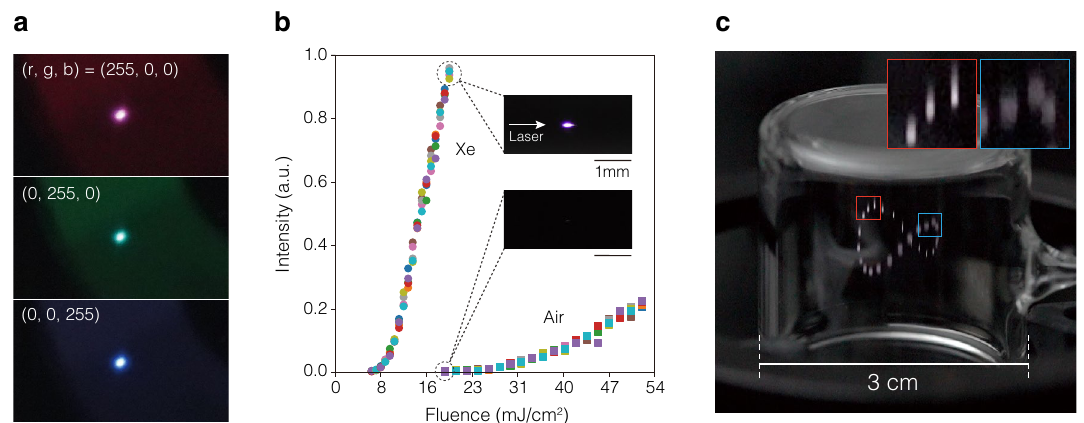
Figure 3. Femtosecond-laser-excited voxels. ( a ) Voxels generated by the re-projection of femtosecond-laser- excited emissions in the air. Three RGB emission colors were achieved by varying the values of the LC color filter ( r , g , b ) to R(255, 0, 0), G(0, 255, 0), and B(0, 0, 255). ( b ) Emission brightness generated in Xe and ambient air versus the irradiated fluence intensity. Macro images of each emission point were captured at 19 mJ/ cm 2 . ( c ) Example graphics in a Xe-filled glass cell. Some of the emission points at different positions are magnified.